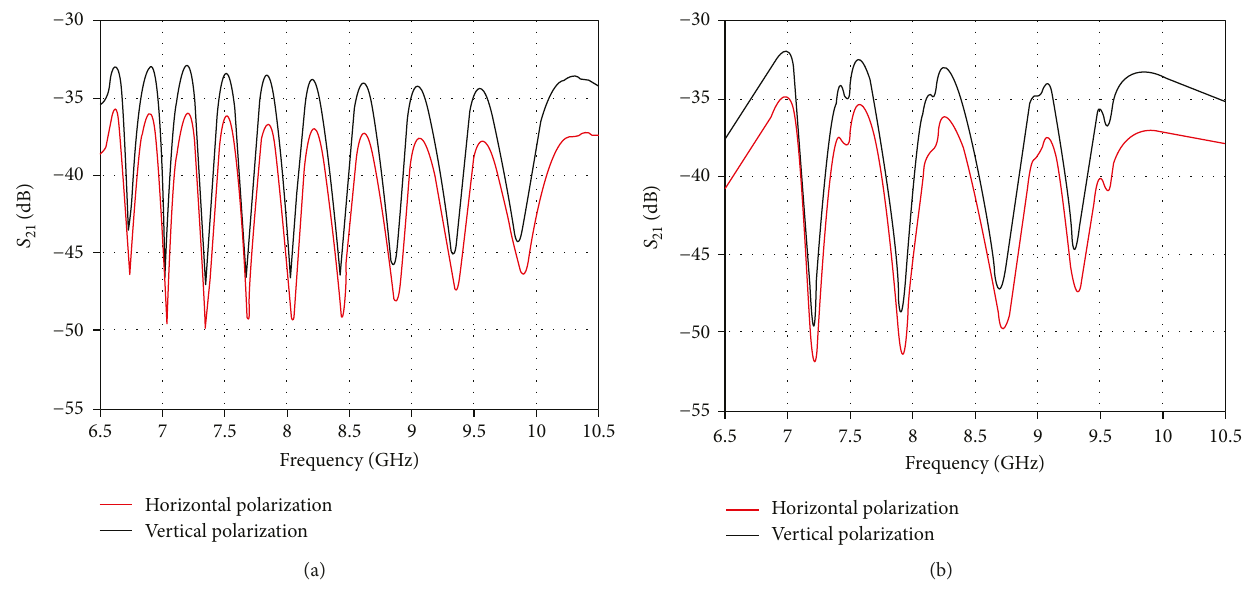
Figure 2: Tag-simulated response under horizontal and vertical excitations for (a) code 111111111 and (b) code Table 1: Comparison of di ff erent chipless RFID tags (bistatic measurements).